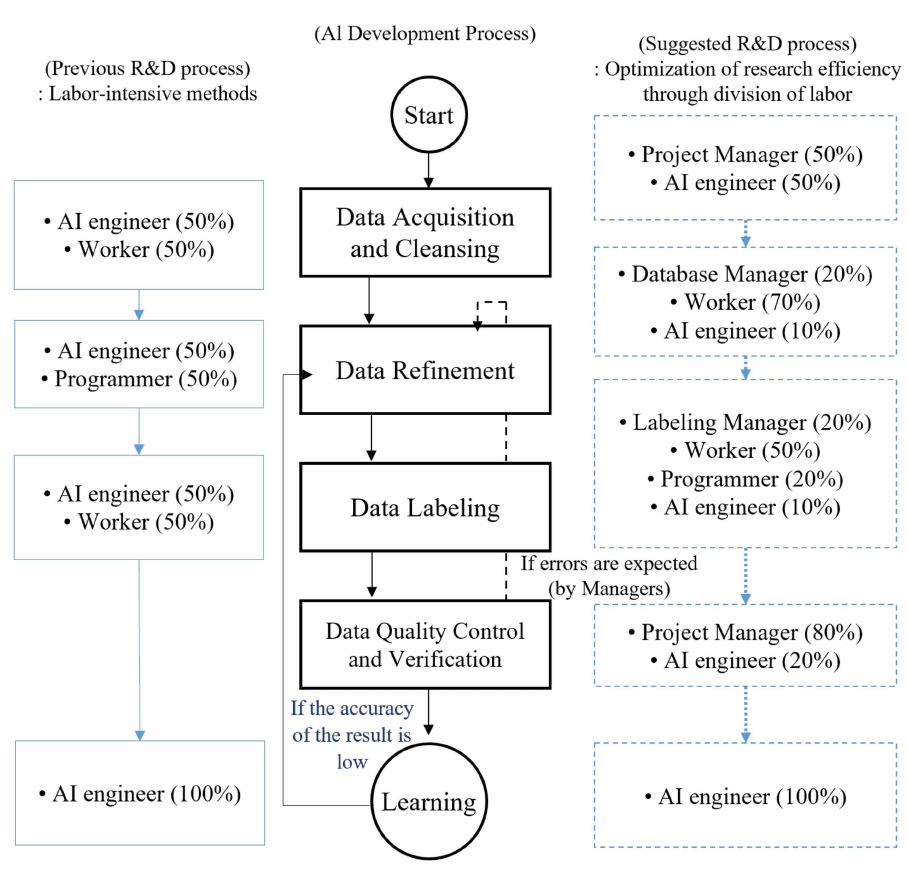
Figure 5. The current R&D method for the human resource structure used in the AI development process and the improved manpower distribution method proposed by the